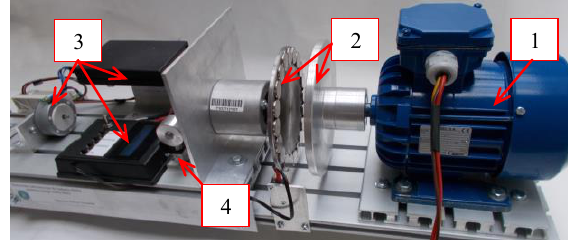
Fig. 5. Test stand; 1 – motor, 2 – eddy-current brake, 3 – control-measuring system, 4 – torque-meter .